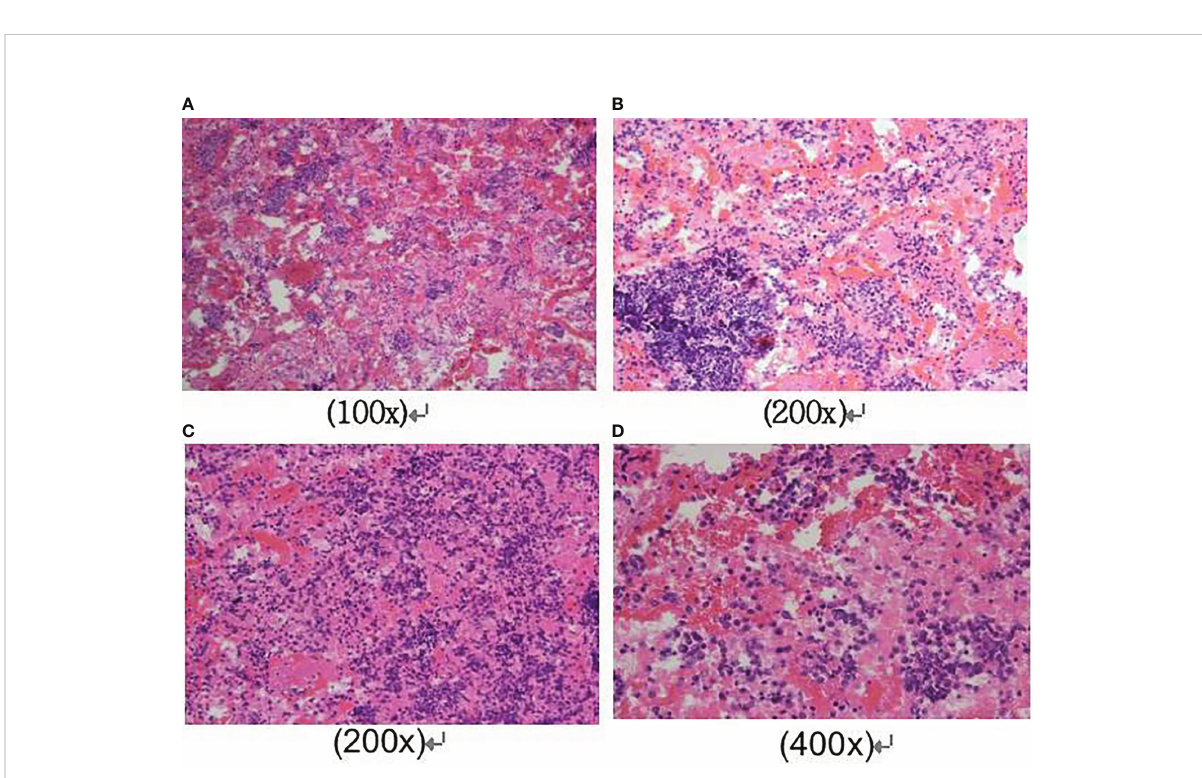
FIGURE 2 Cytological fi ndings of parotid mass biopsy. Hematoxylin and eosin staining of the fi ne-needle aspiration biopsy of the preauricular mass revealed a large number of oat-shaped heteromorphic cells with deep nuclear staining at high magni fi cation, distributed in the shape of chrysanthemum nests. The magni fi cation was as follows respectively: (A) was 100x magni fi cation; (B) and (C) were 200x magni fi cation; (D) was 400x magni fi cation.